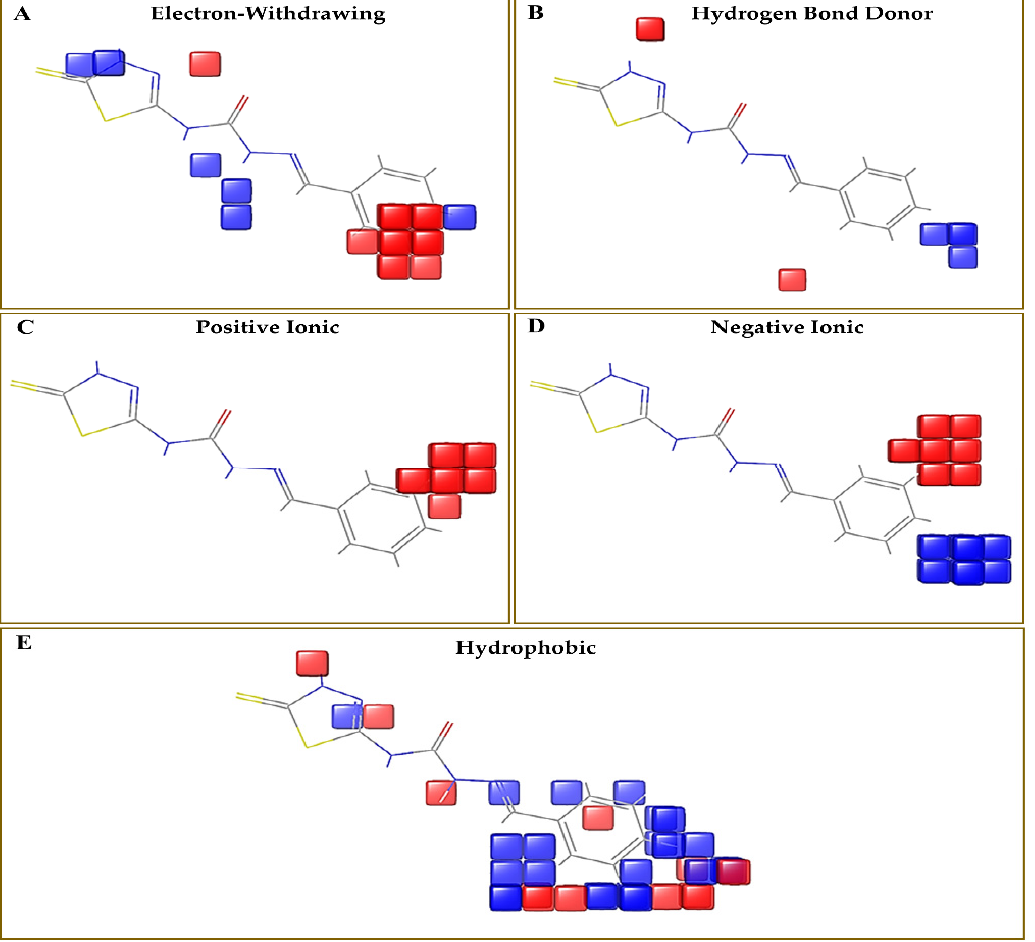
Figure 5. 3D-QSAR model (atom-based) consisting of ( A ) electron-withdrawing, ( B ) hydrogen bond donor, ( C ) positive ionic, ( D ) negative ionic, ( E ) hydrophobic groups, where the blue cubes showed positive coefficients and the red cubes showed negative